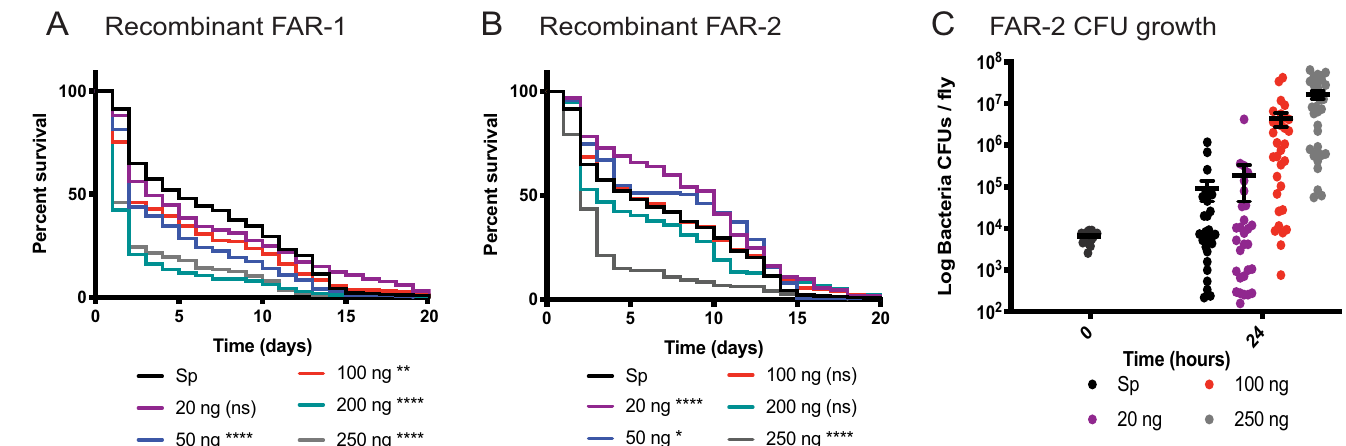
Fig 1. Recombinant FARs reduced fly survival in a dose-dependent manner. A&B) 7,000 CFUs of S . pneumonia ( Sp ) were co-injected with various nanogram doses of either Sc-FAR-1 or -2. C) CFUs were measured at 24 hours post-injection for panel B which shows a trend of increased bacterial growth with increasing protein doses. All controls for survival curves (black) are Sp -injected only, without the addition of FAR proteins. Time 0 CFUs representative of all fly strains. Log-rank test p-value significance indicated by asterisks on Kaplan Meier graphs. CFU graphs show p-value significance of an unpaired t-test (error bars show mean+SEM). Survival curves n � 180, CFU graph n � 24. All raw data available in supplemental